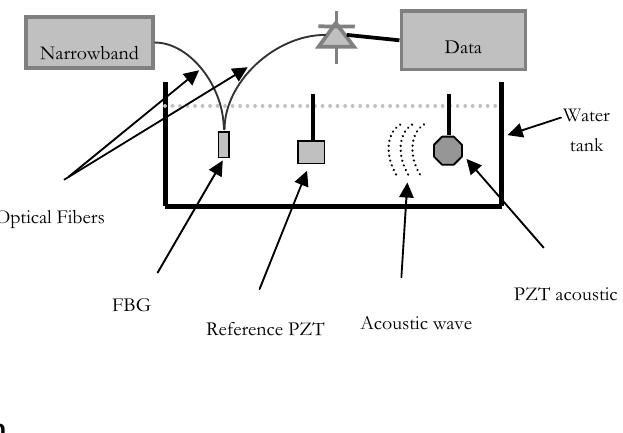
Figure 1. Lateral view of the experimental